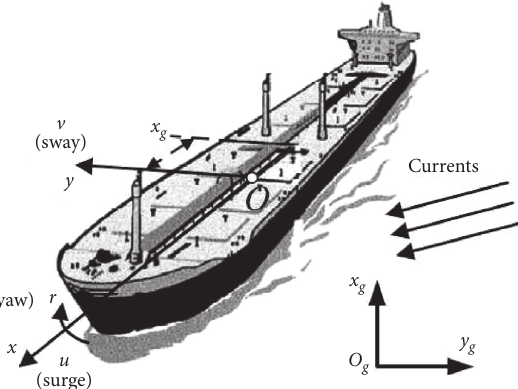
Figure 1: Frames and states of the